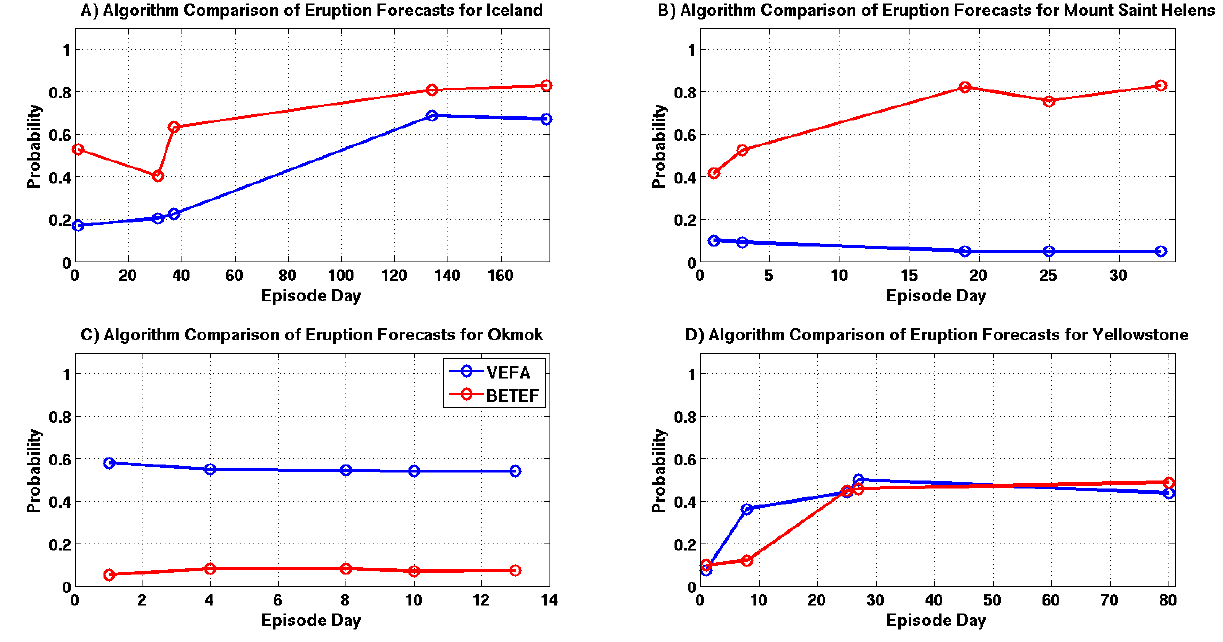
Figure 18. Eruption probability comparisons for selected episode days, where each time sample is highlighted with a circle and the VEFA and BETEF results are shown in blue and red.